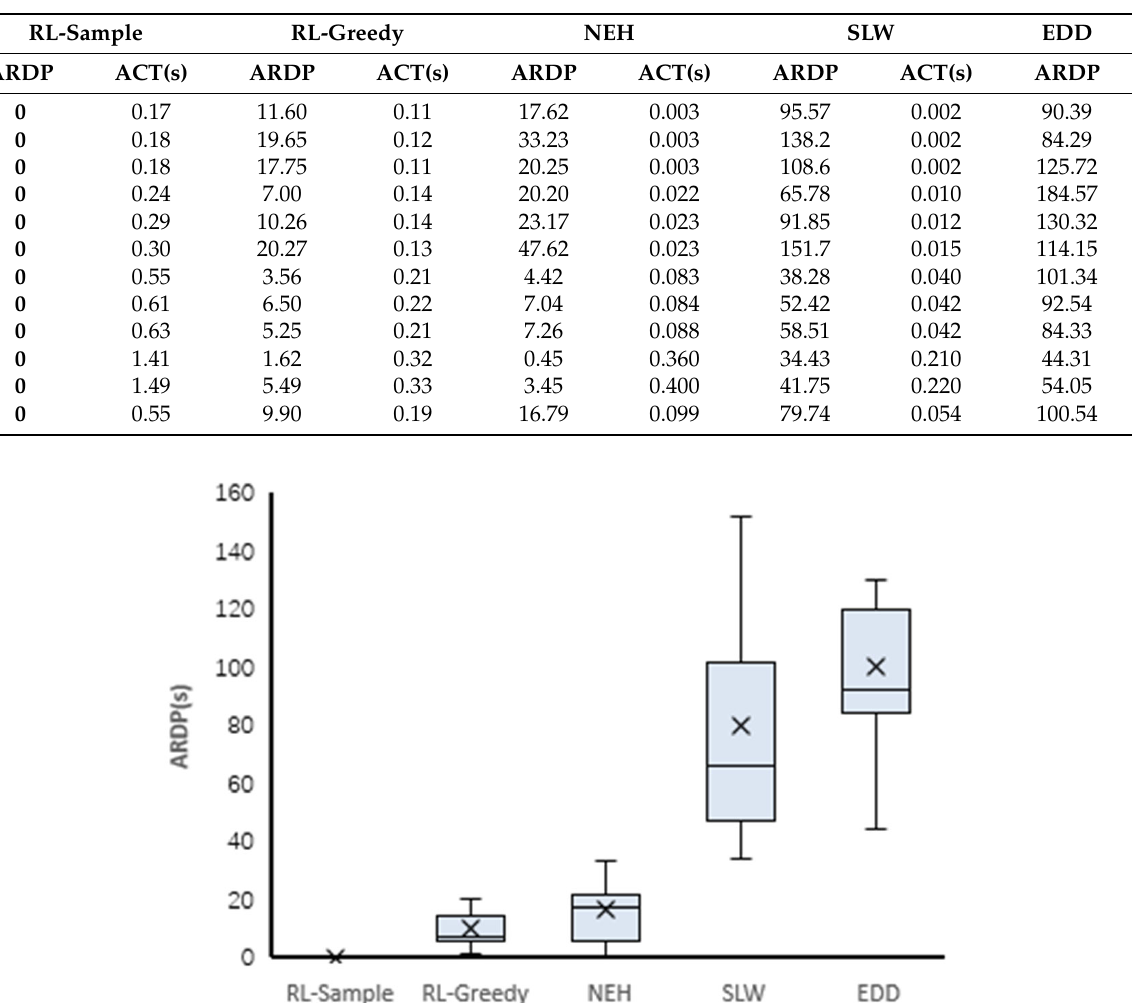
Table 5. Comparison of RL and multiple heuristic algorithms.